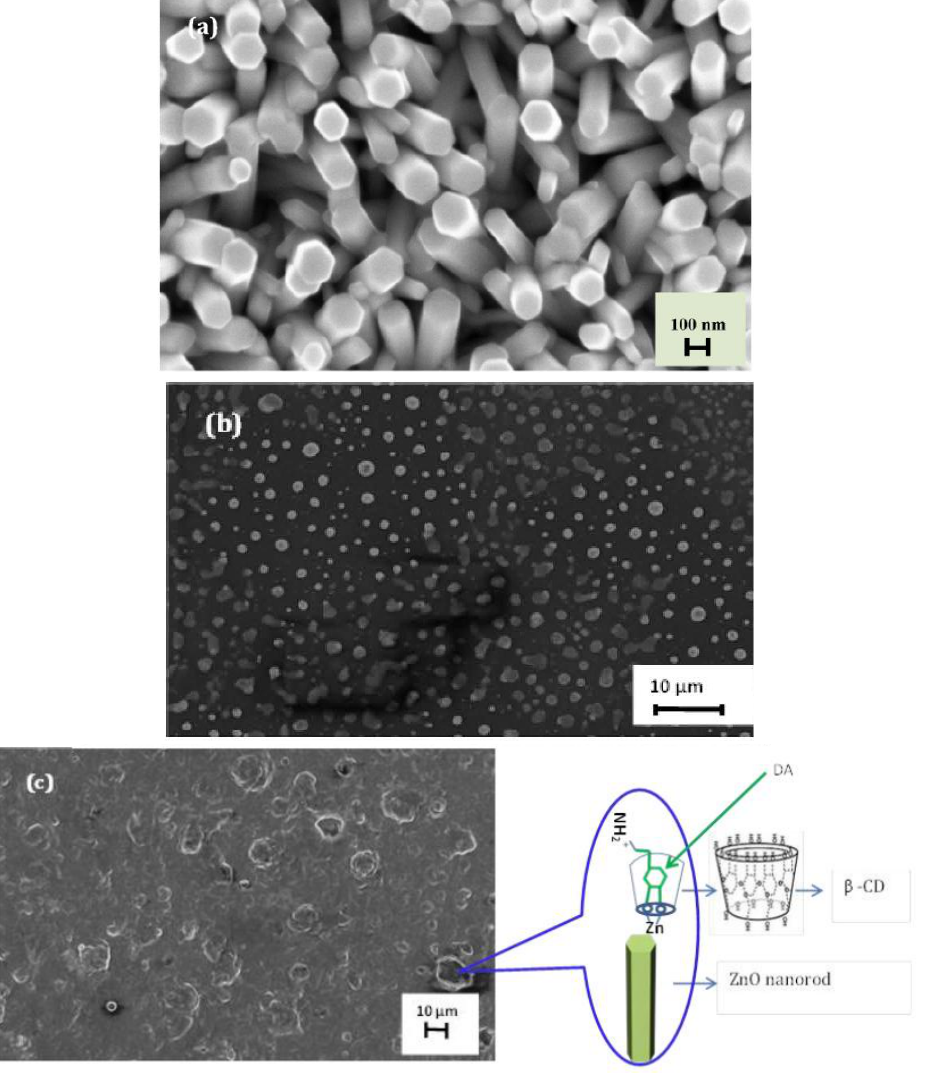
Figure 3. SEM images of ZNRAs grown on Au-coated glass using a low-temperature growth ACG method: ( a ) ZNRAs as grown before membrane immobilization with large aspect ratios; ( b ) and ( c ) before and after measurements respectively, zoom in, proposed mechanism for dopamine intercalation β-Cd to form metal-ligand bonds